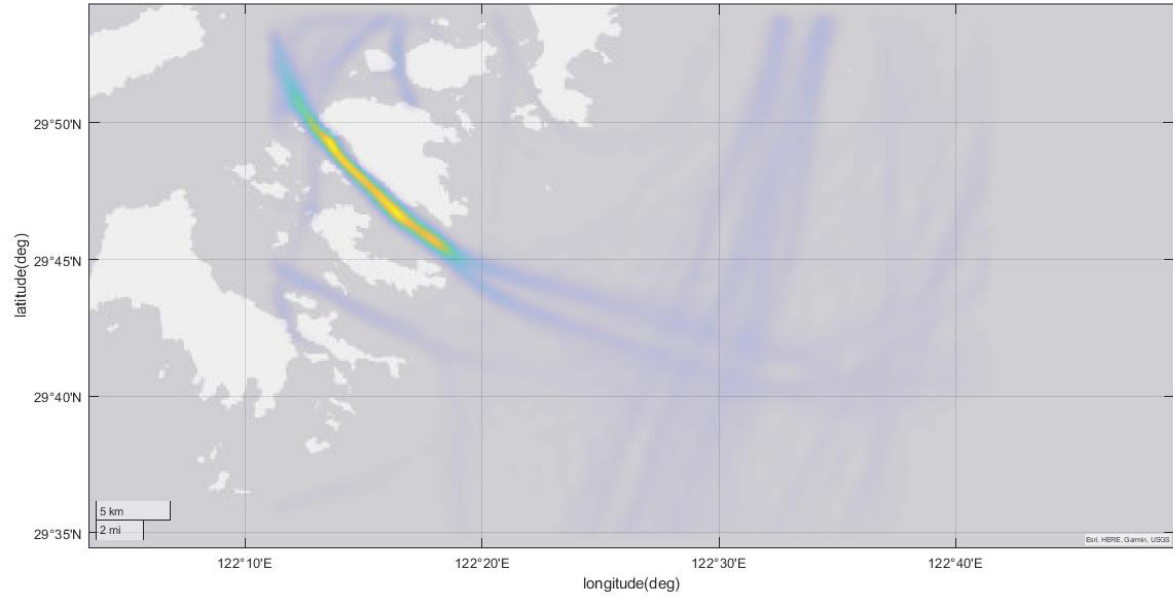
Figure 4. Zhoushan AIS data density map.